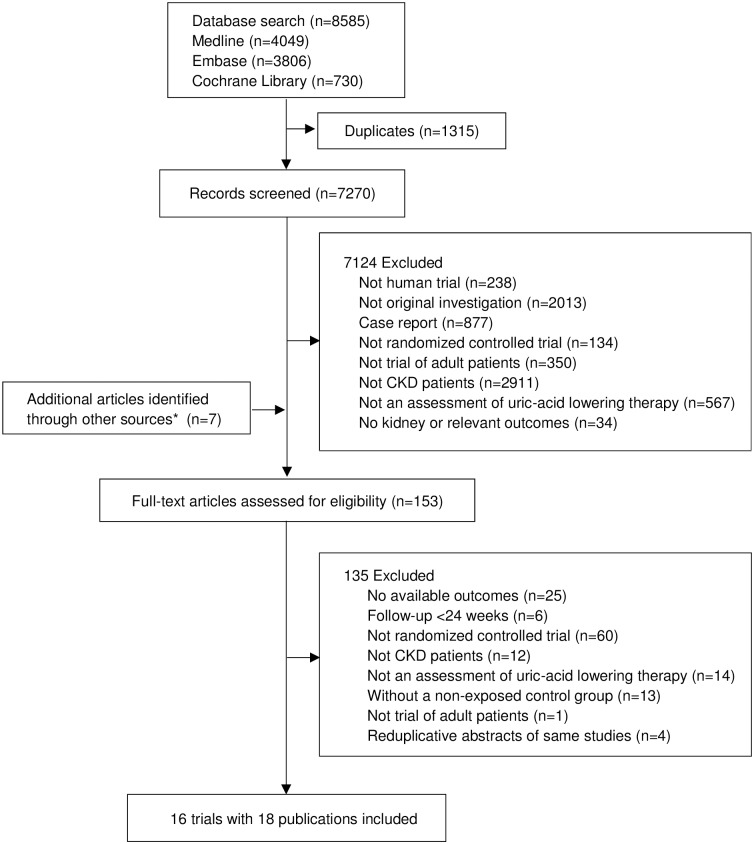
Flow diagram of the search selection.CKD, chronic kidney disease. *Identified from references of other review articles.